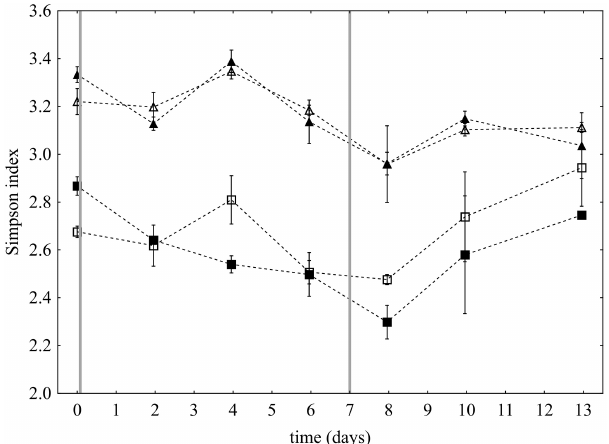
Figure 5. Diversity (Simpson index) of the total (squares) and ac- tive (triangles) bacterial community in D- (filled symbols) and C- mesocosms (empty symbols) at 5m depth during the DUNE-R ex- periment. Grey vertical bars represent the dust seedings.